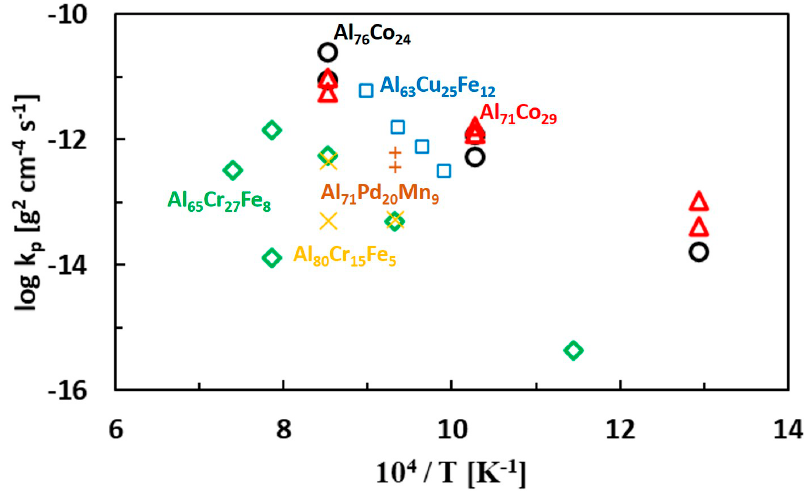
Figure 14. Parabolic rate constants for metal oxidation of Al-TM complex metallic